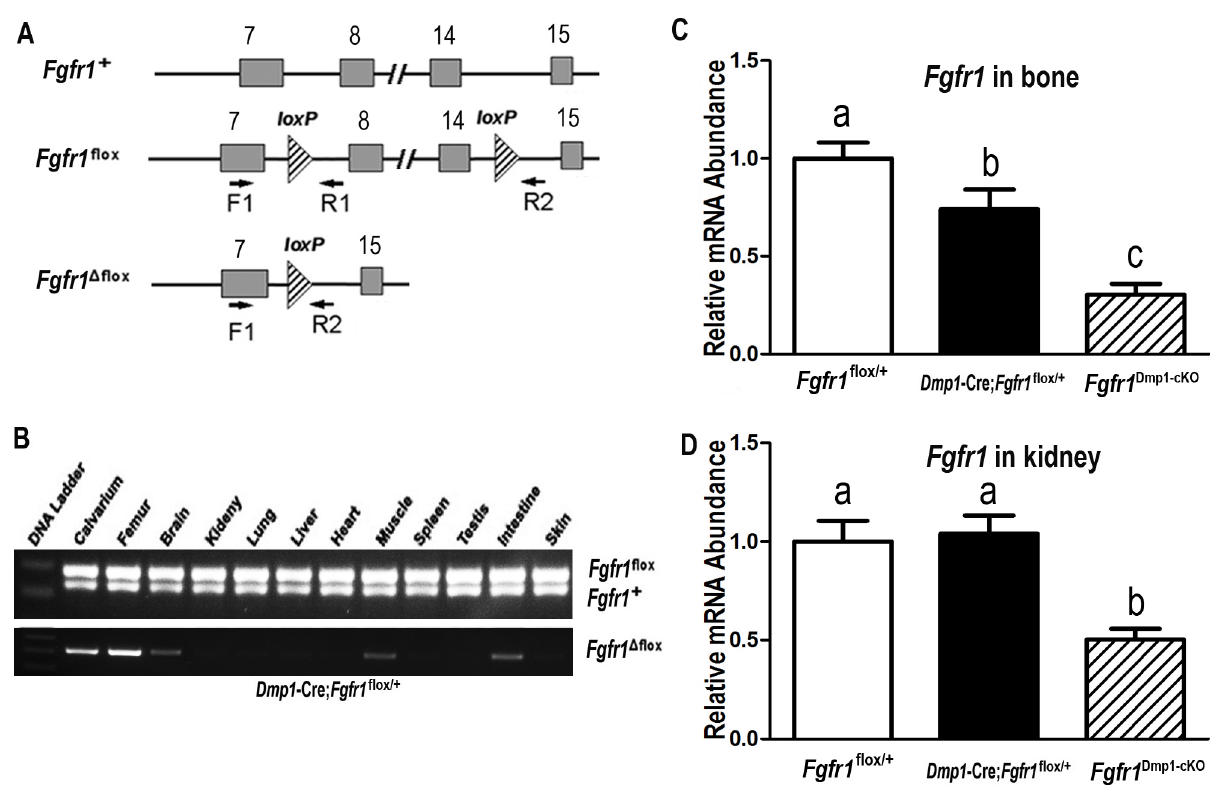
Figure 1. Dmp1 -Cre-mediated conditional deletion of Fgfr1 from the floxed Fgfr1 allele ( Fgfr1 flox ) in different tissues. (A) Schematic illustration of wild-type ( Fgfr1 + ), floxed Fgfr1 allele before ( Fgfr1 flox ) and after deletion ( Fgfr1 D flox ) of the lox P cassette containing Exon 8–14 via Cre- mediated recombination. ‘‘//’’ stands for all the Introns and Exons omitted between Exon 8 and Exon 14. (B) Genotype PCR analysis of different tissues that were harvested from heterozygous Dmp1 -Cre; Fgfr1 flox/ + mice at 6 weeks of age. Both Fgfr1 wild-type and floxed alleles existed in all tested tissues of heterozygous Dmp1 -Cre; Fgfr1 flox/ + mice. However, Dmp1 -Cre-mediated recombination of excised floxed Fgfr1 ( Fgfr1 D flox) allele occurred in bone tissues such as calvarias and femur, but also had a leakage in the brain, muscle, and intestine. (C and D) Real-time RT-PCR analysis of total Fgfr1 transcripts in bone and kidney. Expression of total Fgfr1 transcripts was performed using Fgfr1- allele-specific primers as described in Materials and Methods. The normal Fgfr1 + vs cyclophilin A is normalized to the mean ratio of 5 control Fgfr1 flox/ + mice, which has been set to 1. Data are expressed as a relative abundance of wild-type ( Fgfr1 + and Fgfr1 flox ) mRNA messages in control Fgfr1 flox/ + mice, heterozygous Dmp1 -Cre; Fgfr1 flox/ + , and homozygous Dmp1 -Cre; Fgfr1 flox/null ( Fgfr1 Dmp1-cKO )-null mice. Values sharing the same superscript in different groups are not significantly different